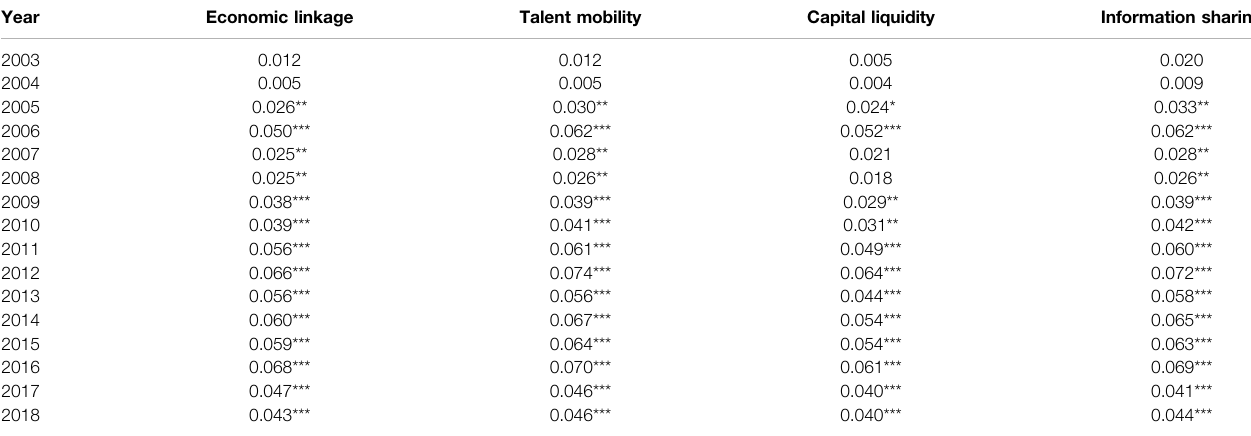
TABLE 2 | Spatial correlation test of the green economic ef fi ciency in the YREB.